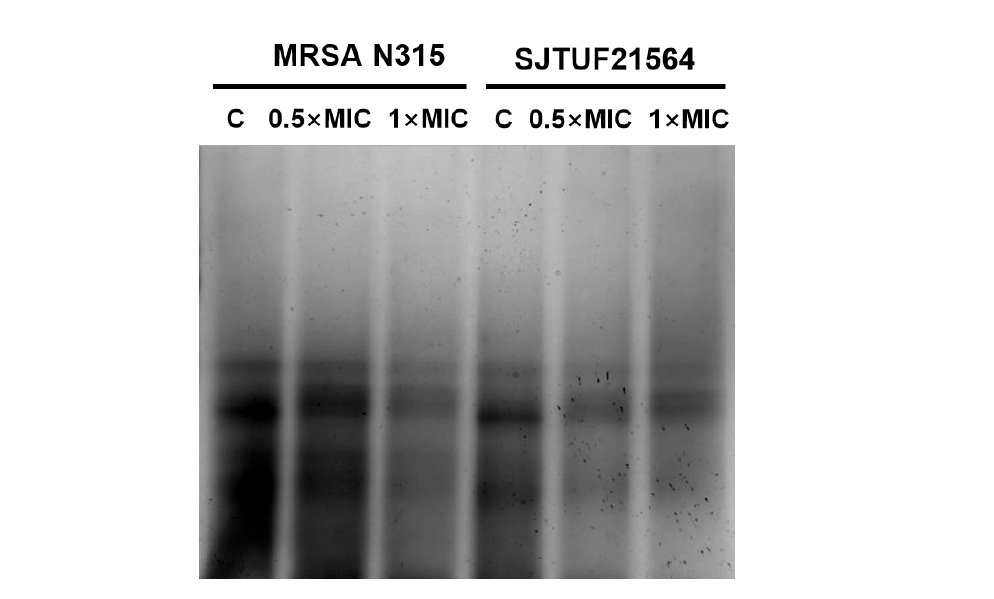
Figure 5. WTA-PAGE analysis of S. aureus after inhibition with LBA at different concentrations. Samples shown here were resolved in polyacrylamide gels and visualized with Alcian blue/silver staining.